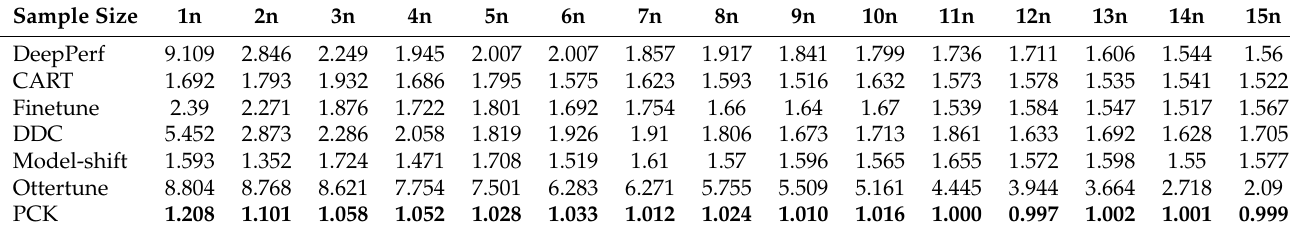
Table 4. MRE comparison among different approaches for SQLite (version 3.31.1–3.36.0).